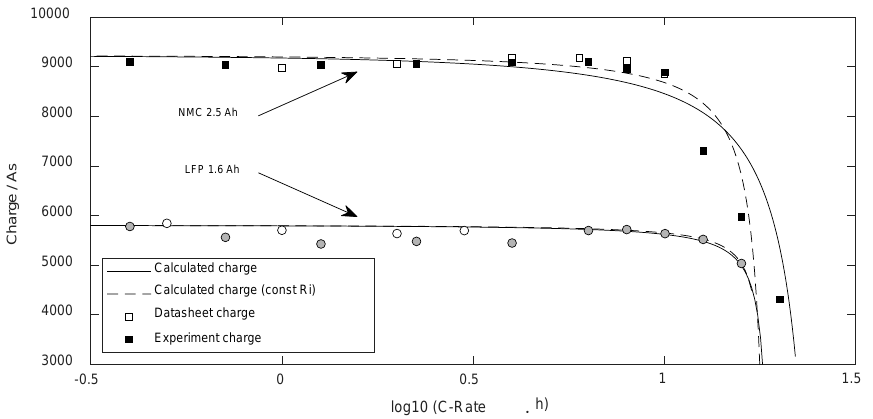
Figure 6. Available Charge Q dis ( I ) dependent on the discharge current.